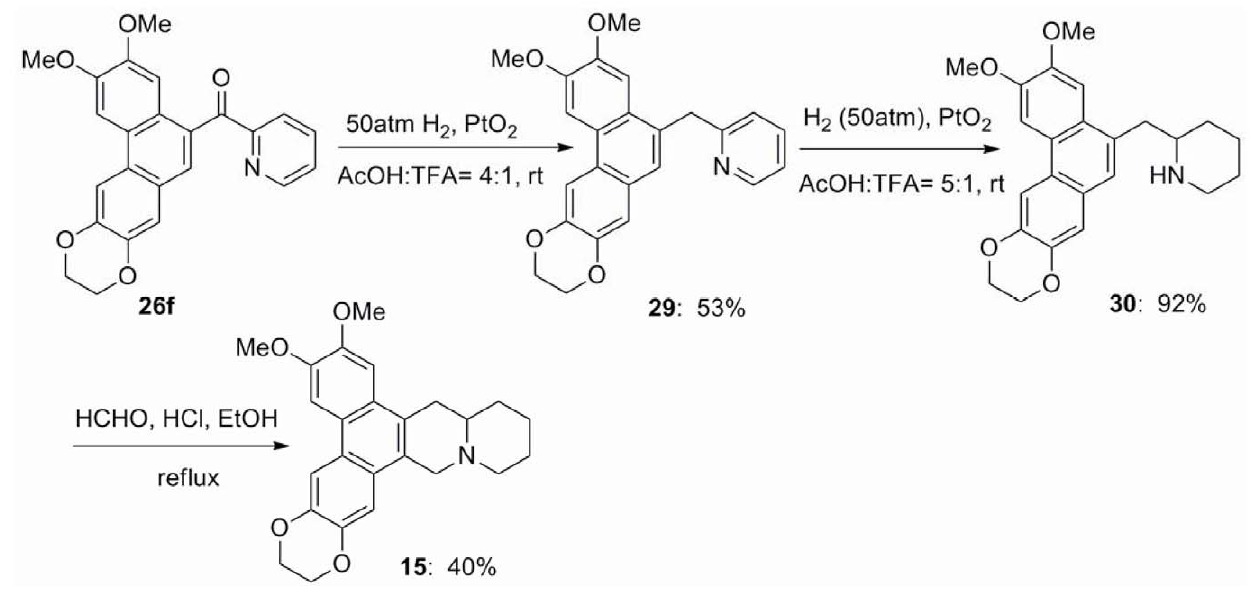
Figure 3. Synthesis of compound 15.